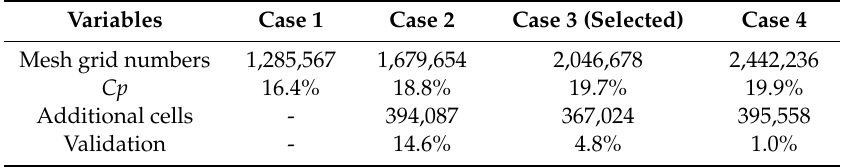
Table 1. Grid independence tests by comparing di ff erent mesh numbers with Cp